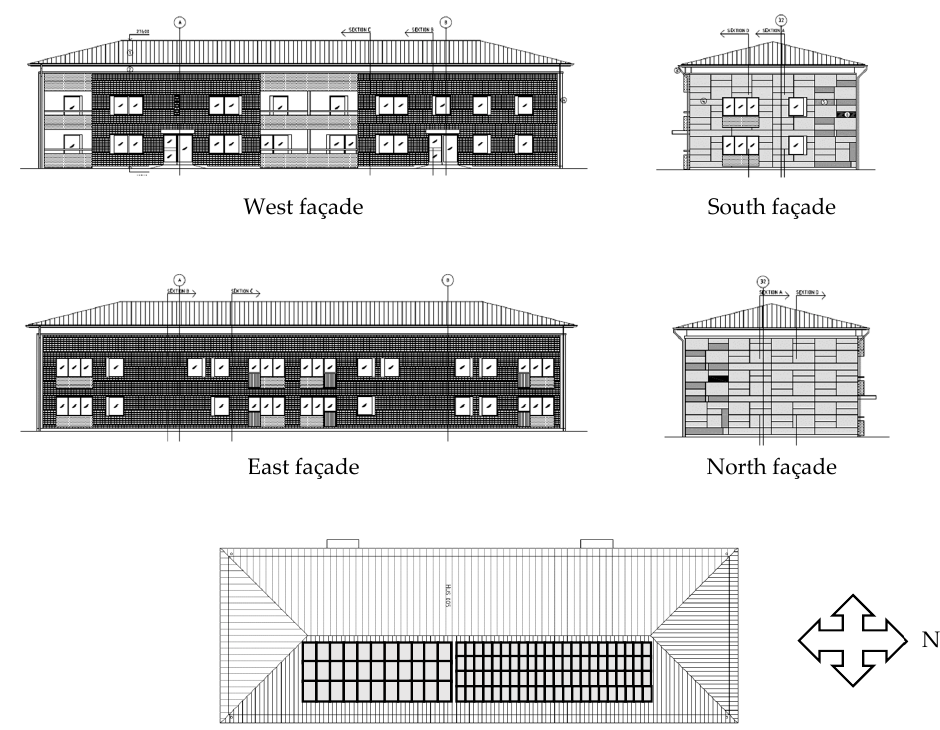
Figure 2. Blue print showing the architectural design of the case building and geographical orientation of the building and photovoltaics.